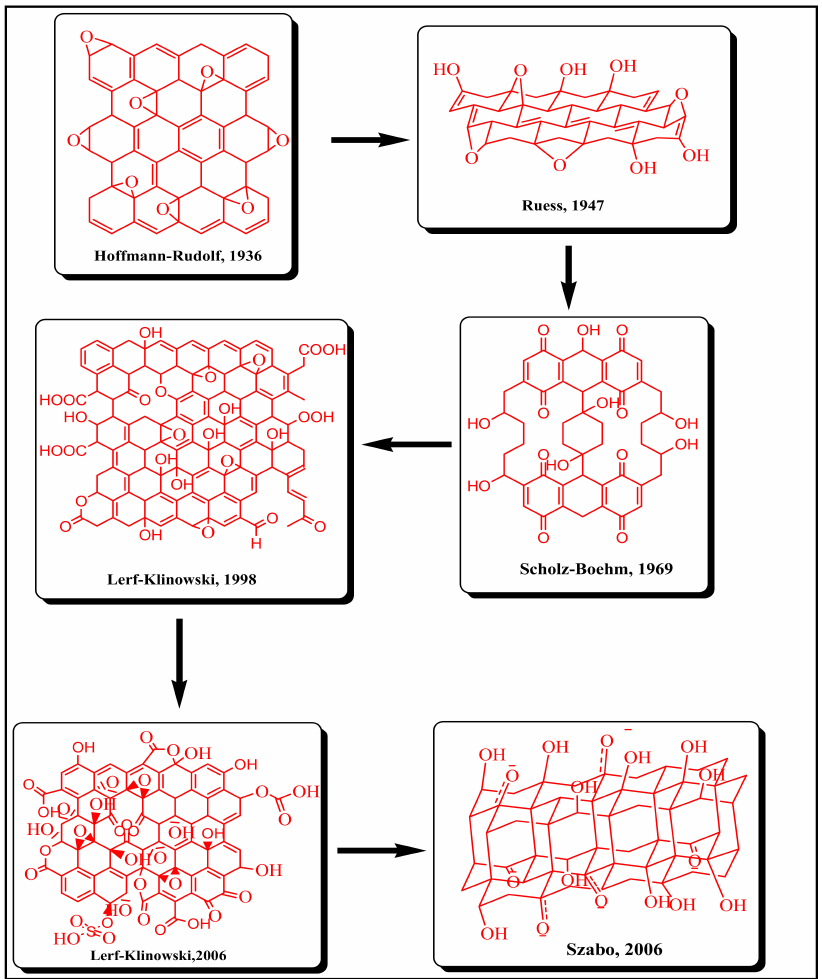
Figure 12. Schematic representation of the year-wise progress in proposed structures of graphene oxide